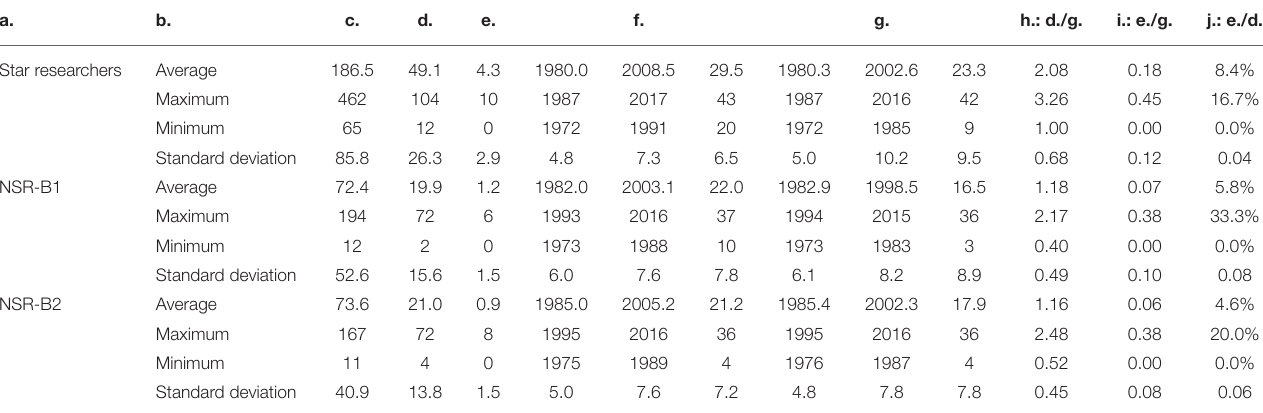
TABLE 6 | Comparison between star researchers and non-star researchers in the R&D department of a company: a. Researcher, b. Statistics, c. Total number of patents, d. Number of patents filed as a primary inventor, e. Number of highly cited patents * filed as a primary inventor, f. Period of filing patents (first patent, last patent, period